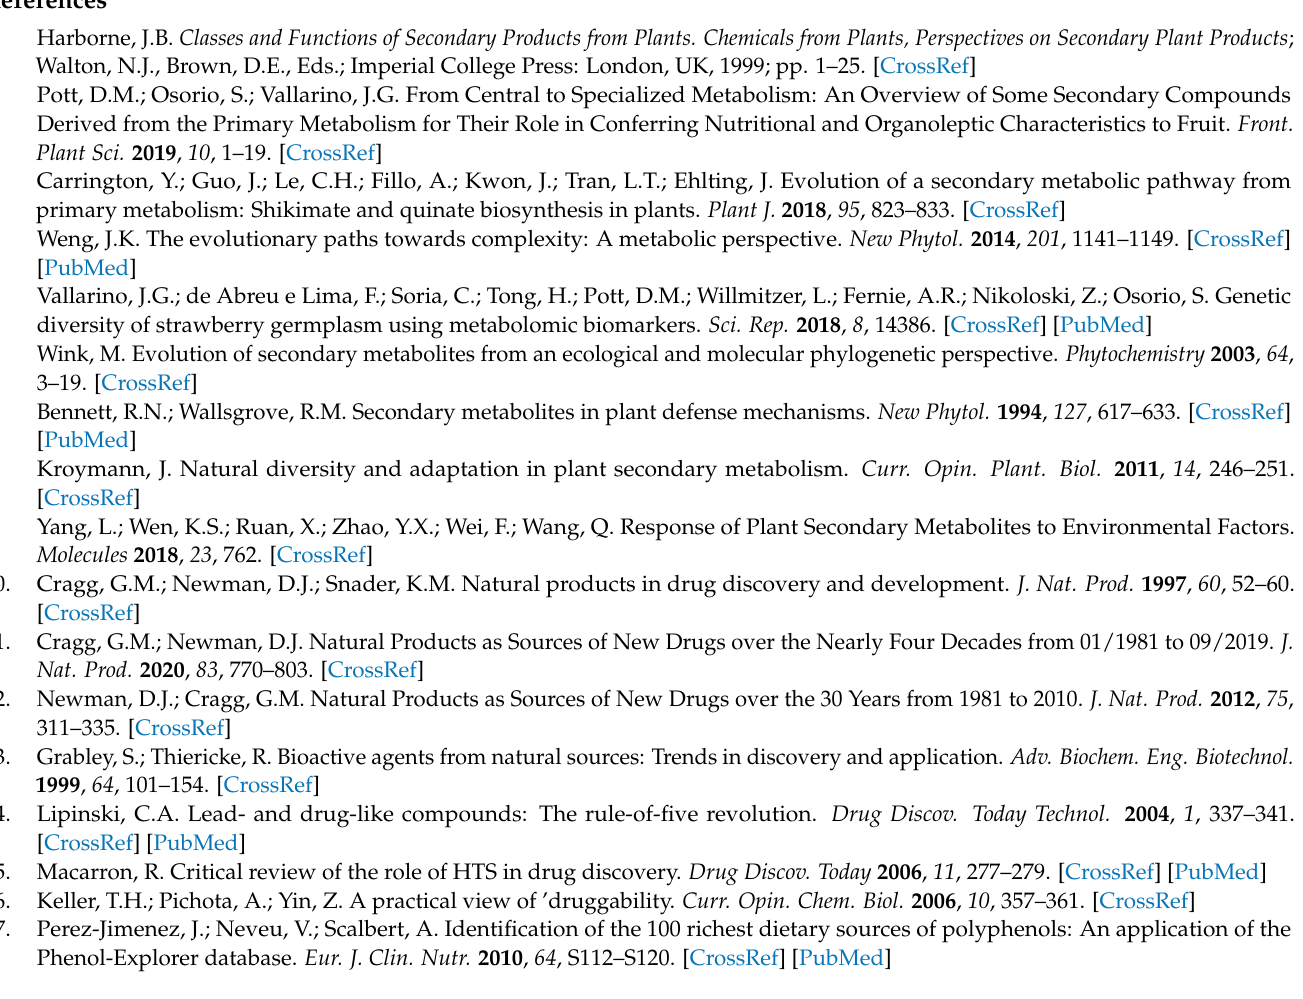
(4W6E), Figure S2: Hydrogen bond interactions of luteolin-7-O-glcoside with TNKS1 (4W6E), Figure S3: Hydrogen bond interactions of luteolin-8-C-glcoside with TNKS1 (4W6E), Figure S4: Hydrogen bond interactions of caffeic acid with TNKS1 (4W6E), Figure S5: Hydrogen bond interac- tions of gentisic acid with TNKS1(4W6E), Figure S6: Hydrogen bond interactions of p-aminobenzoic acid with TNKS1(4W6E), Figure S7: Hydrogen bond interactions of Co-crystallized FLN with TNKS2 (4HKI), Figure S8: Hydrogen bond interactions of luteolin-7-O-glcoside with TNKS2 (4HKI), Figure S9: Hydrogen bond interactions of luteolin-8-C-glcoside with TNKS2 (4HKI), Figure S10: Hy- drogen bond interactions of caffeic acid with TNKS2 (4HKI), Figure S11: Hydrogen bond interactions of gentisic acid with TNKS2 (4HKI), Figure S12: Hydrogen bond interactions of p-aminobenzoic acid with TNKS2 (4HKI), Figure S13: Atomic labeling scheme for A: luteolin-7-O-glucoside; B: luteolin-8- C-glucoside; C: caffeic acid; D: gentisic acid; E: aminobenzoic acid, as arbitrary provided by Spartan software upon energy